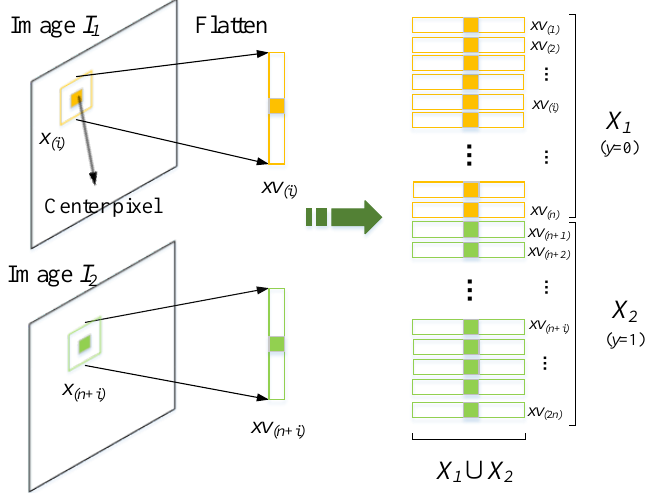
Figure 6. The generation of training data for our pretext task. The sample set X 1 from I 1 is labeled with 0. The sample set X 2 from I 2 is labeled with 1. A stack of X 1 and X 2 , i.e., X 1 ∪ X 2 , constitutes the labeled input data. The neighbor of each pixel is flattened as a